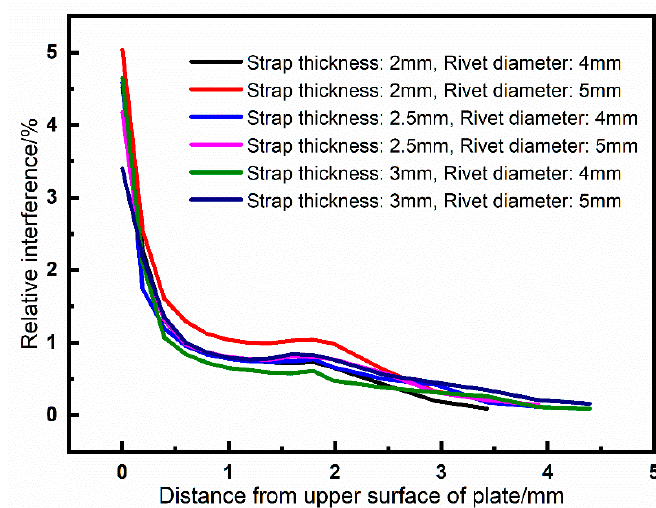
Figure 10. Interferences along the selected path of riveted joints. The path is started from the driven head side to the rivet head side. The X -axis is the distance from the upper surface of plate to the lower surface of the strap. The Y -axis is the relative interference expressed in Equation (2).